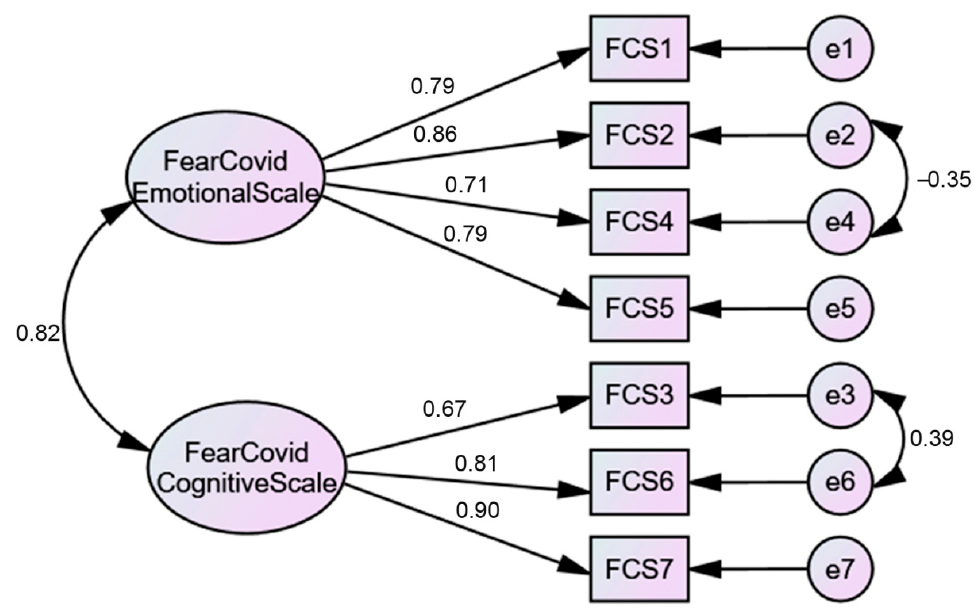
Figure 2. Two-factor CFA model.